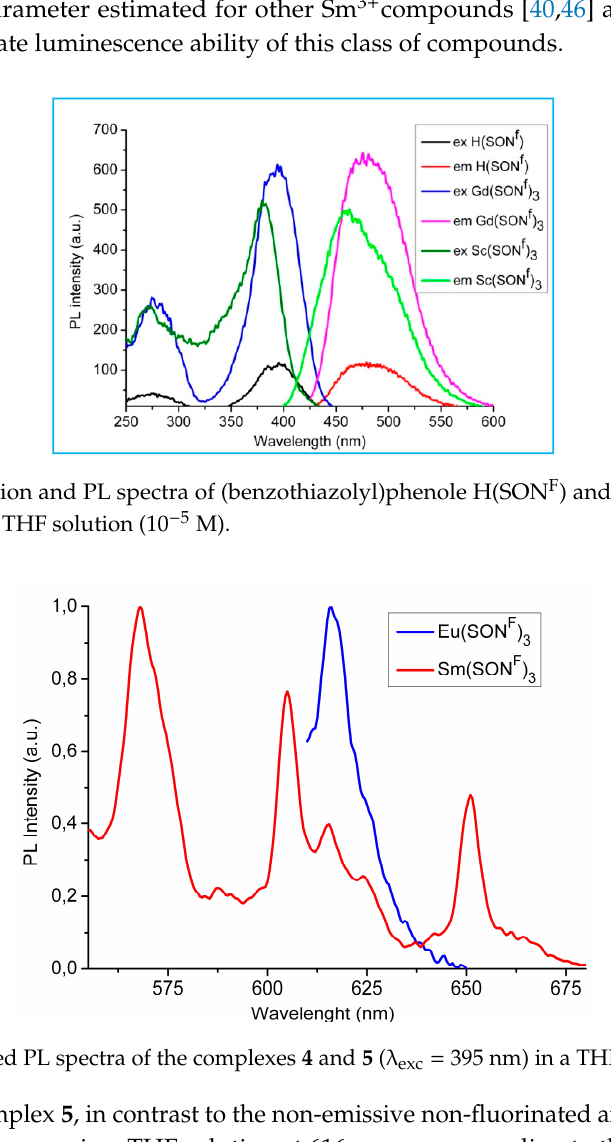
Figure 8. Normalized PL spectra of the complexes 4 and 5 ( λ exc = 395 nm) in a THF solution (10 − 4 M).